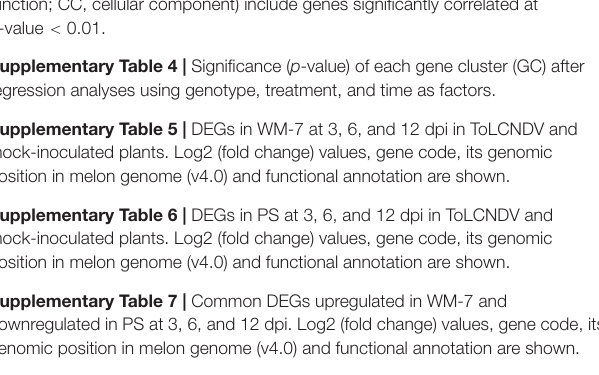
downregulated genes, respectively. Supplementary Table 1 | Primer sequences used in qPCR for DEG confirmation